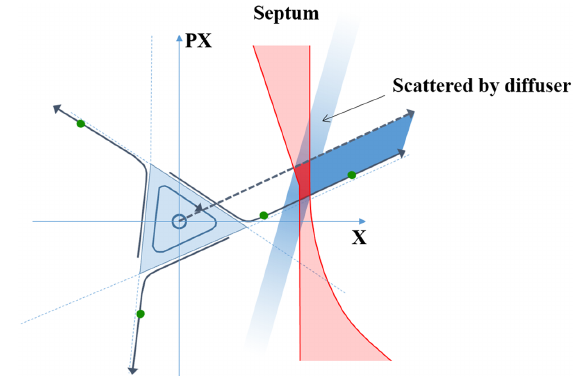
FIG. 1. Separatrices and ES at the septum entrance, showing the shape of the septum defined by phase-space coordinates of particles which will intercept it.